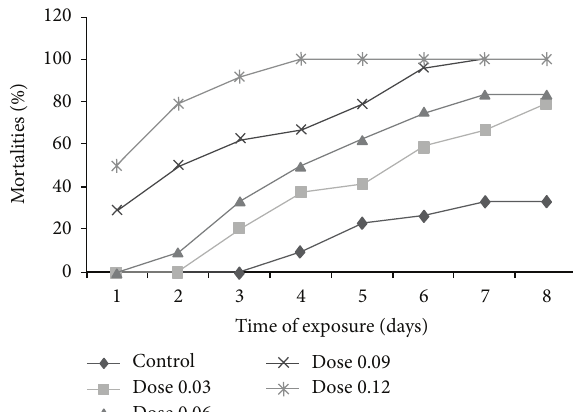
Figure 1: Evolution of in vitro mortalities according to time and doses of essential oils of C. ambrosoides leaves contained in the